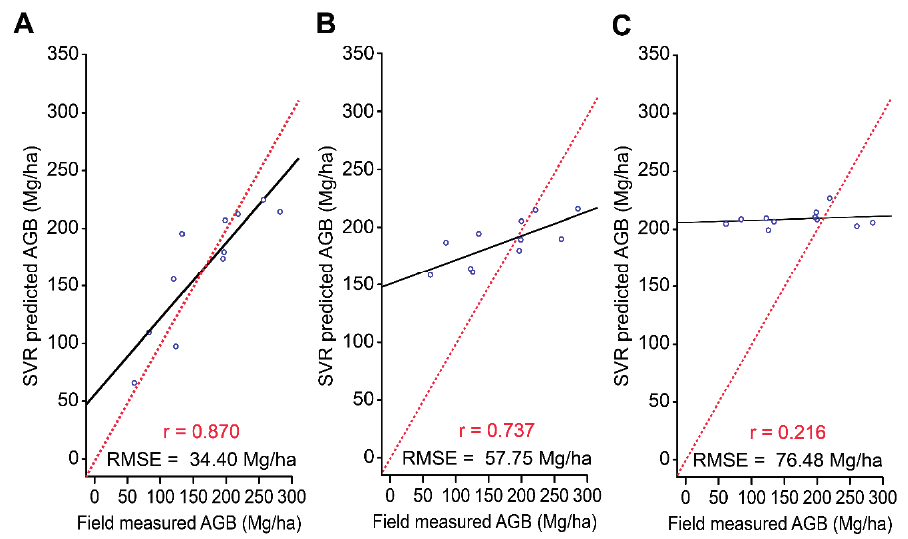
Figure 8. SVR-predicted AGB vs. field-measured AGB, as derived from VHR imagery via the Gabor method using ( A ) HCV + VCH, ( B ) HCV only and ( C ) TV only. Solid black lines represent regression lines; red dashed lines represent 1:1 correspondence lines.